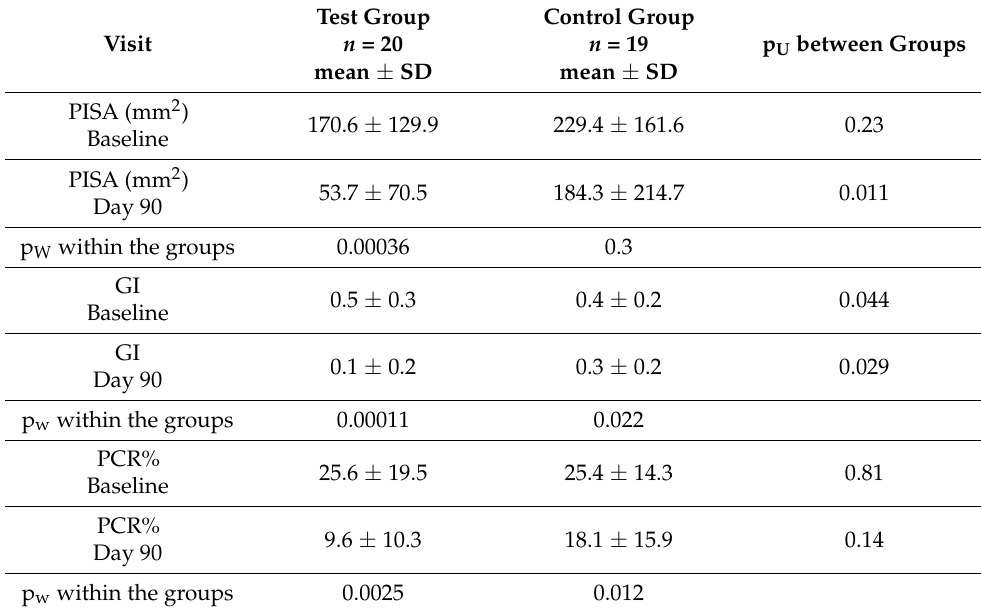
Table 3. Periodontal Inflamed Surface Area (PISA), Gingival Index (GI) and Plaque Control Record